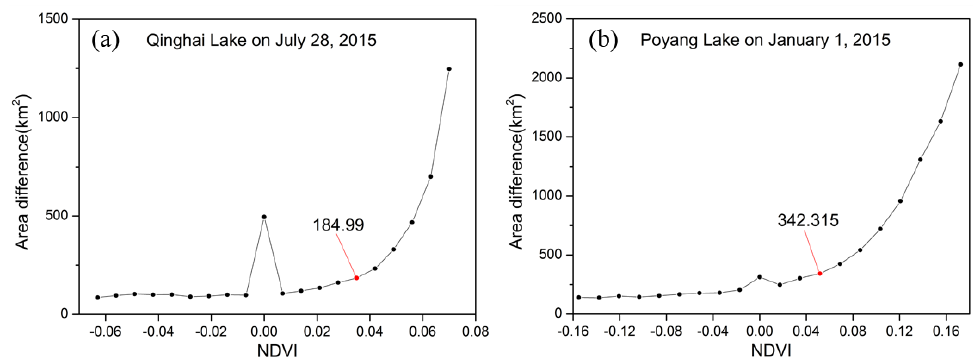
Figure 3. Normalized difference vegetation index—water area difference (water area from NDVI i subtract water area from NDVI i-1 , i = 1, 2, …, 21, NDVI i > NDVI i-1 ) curves and the optimal normalized difference vegetation index threshold for Qinghai Lake ( a ) and Poyang Lake ( b ).